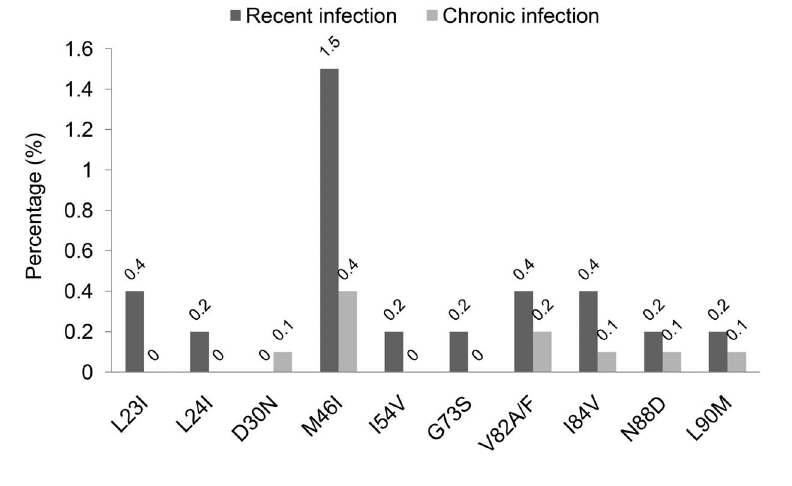
Figure 2. Distribution of protease resistance-associated mutations among 1,798 antiretroviral-naive HIV-infected patients.